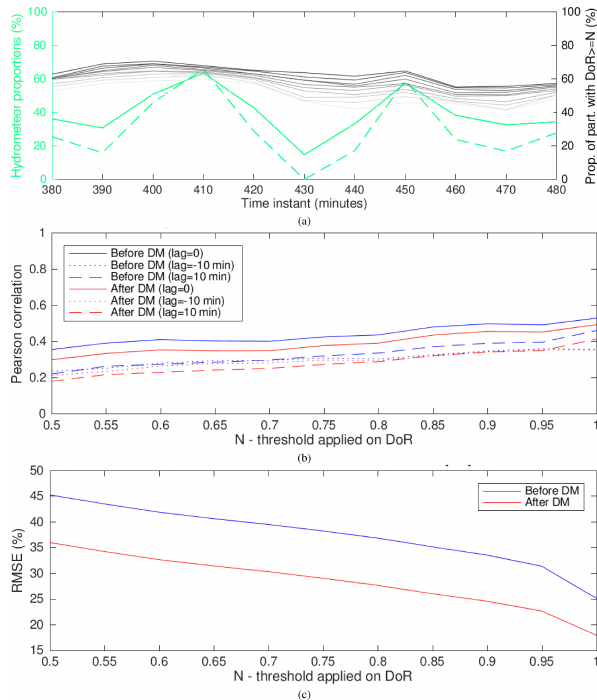
Figure 15. Radar vs. MASC, detection of rimed particles: (a) tem- poral evolution of event no. 2, with the shades of gray correspond- ing to different thresholds ( ≥ ) applied to DoR (dark corresponding to 0.5; light corresponding to 1), green dashed line being the pro- portion of RPs before the de-mixing and green solid line being the proportion of RPs after the de-mixing; (b) cross correlation for all events from Table 2; and (c) root mean square error (RMSE) for all events from Table